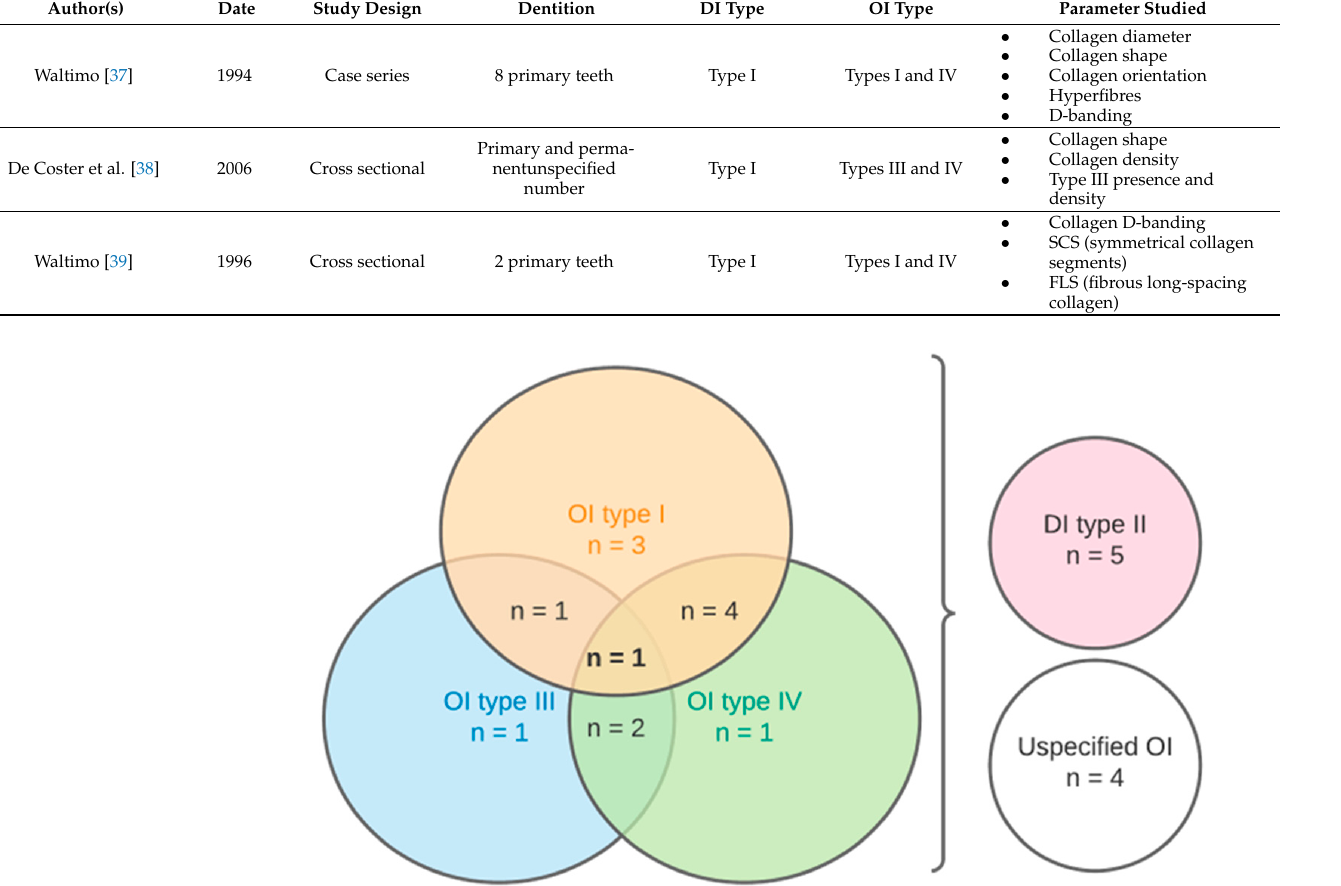
Figure 3. Distribution of studies based on types of osteogenesis imperfecta. Table 3. Included studies, date of publication, type of OI and collagen parameter studies.